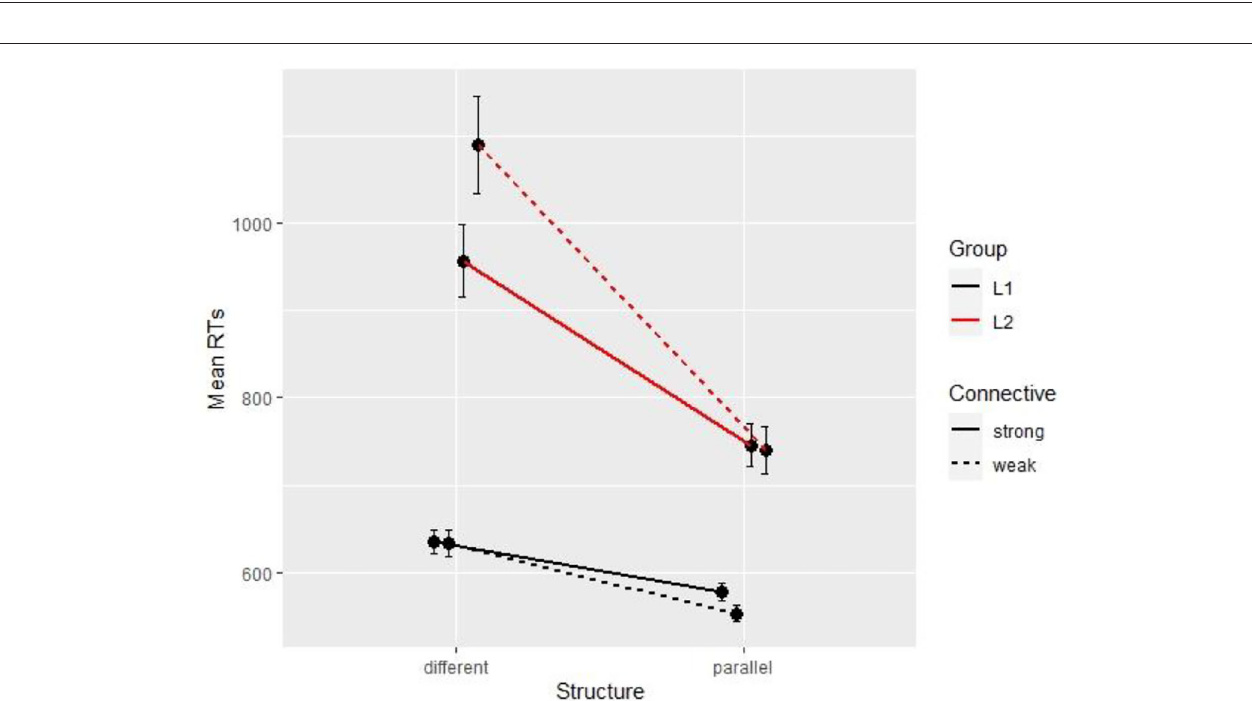
FIGURE 5 | Mean reading times per condition and per group (Experiment 3, Segment